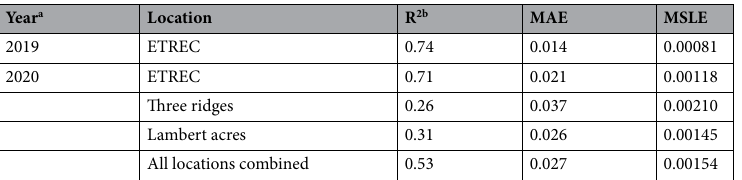
Yearly cumulative emergence. To better understand the entirety of P. annua emergence throughout autumn, yearly cumulative emergence data were regressed against CDD 21C accumulation and fit to a ruminal degradation curve [Eq. (2)] where,